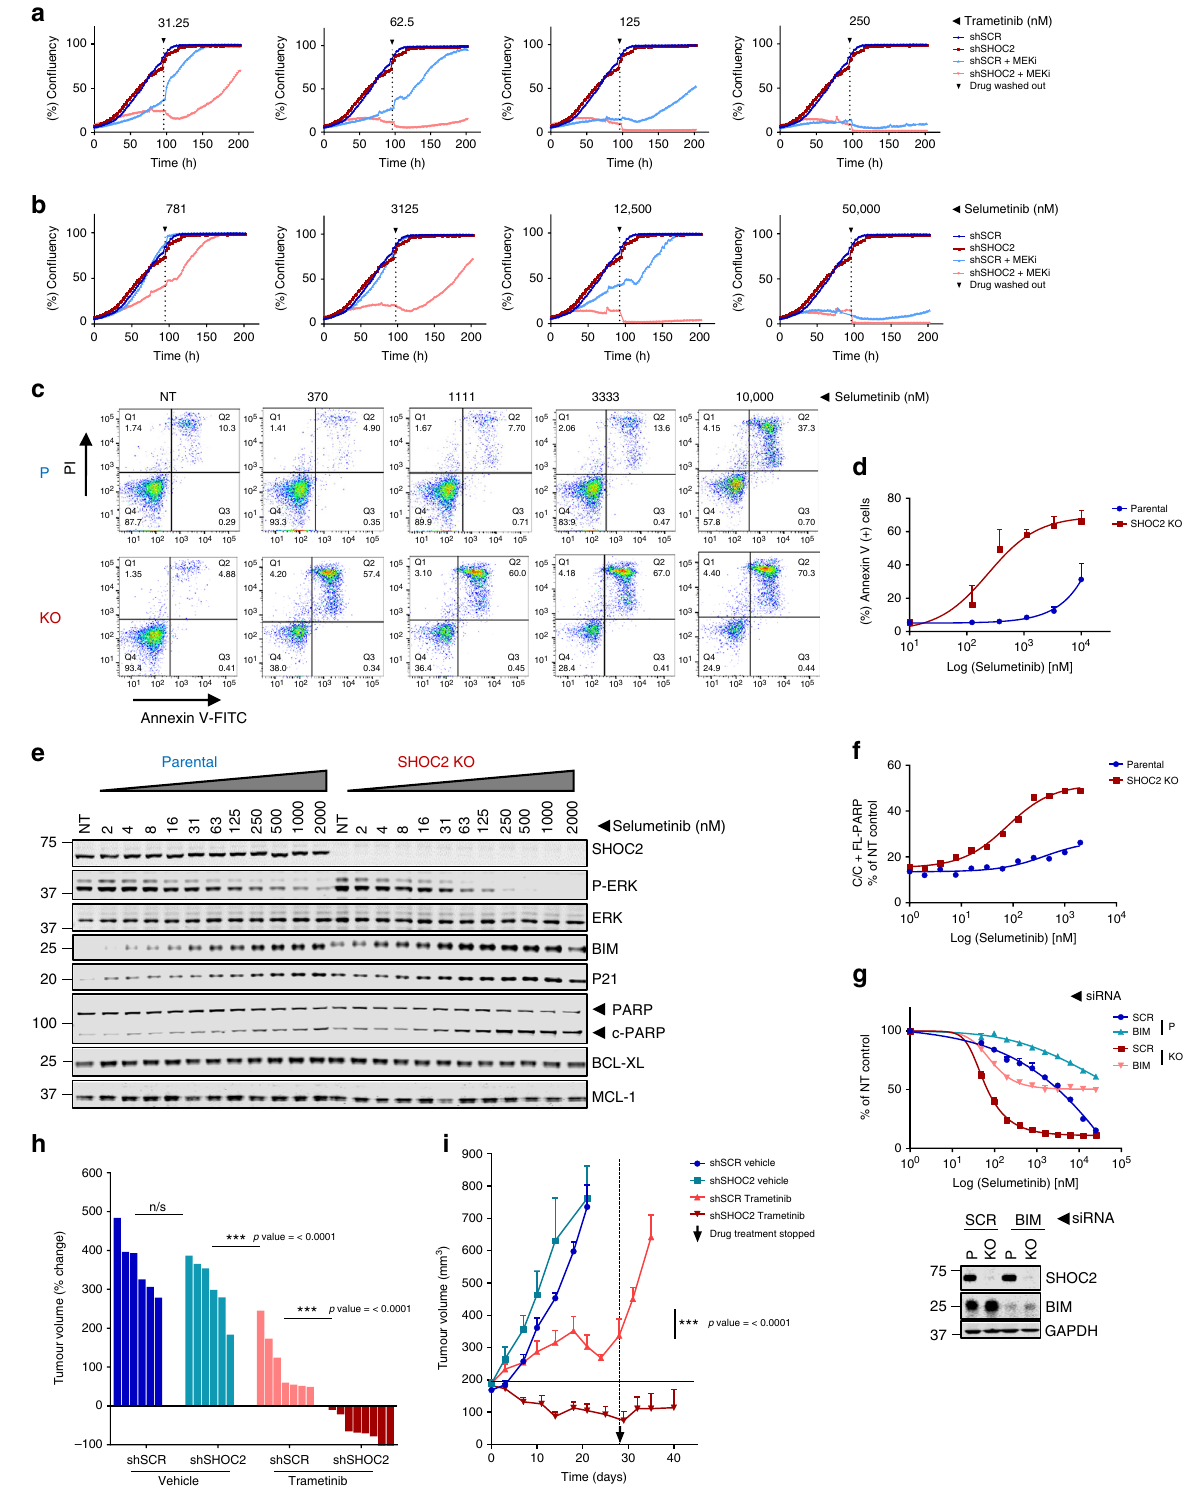
Animal husbandry . All mice were maintained in individually ventilated cages (IVCs). Athymic nude mice received autoclaved food, water and bedding according to institutional guidelines. All animal experiments were conducted under an appropriate UK project license in accordance with the regulations of UK home of fi ce for animal welfare according to ASPA (animal scienti fi c procedure Act 1986). Statistical analysis . Data are presented as mean± SD unless otherwise stated. Signi fi cance was determined with GraphPad Prism 7 software using the Student ’ s t -test where ∗ p < 0.05, ∗∗ p <0.01 or ∗∗∗ p <